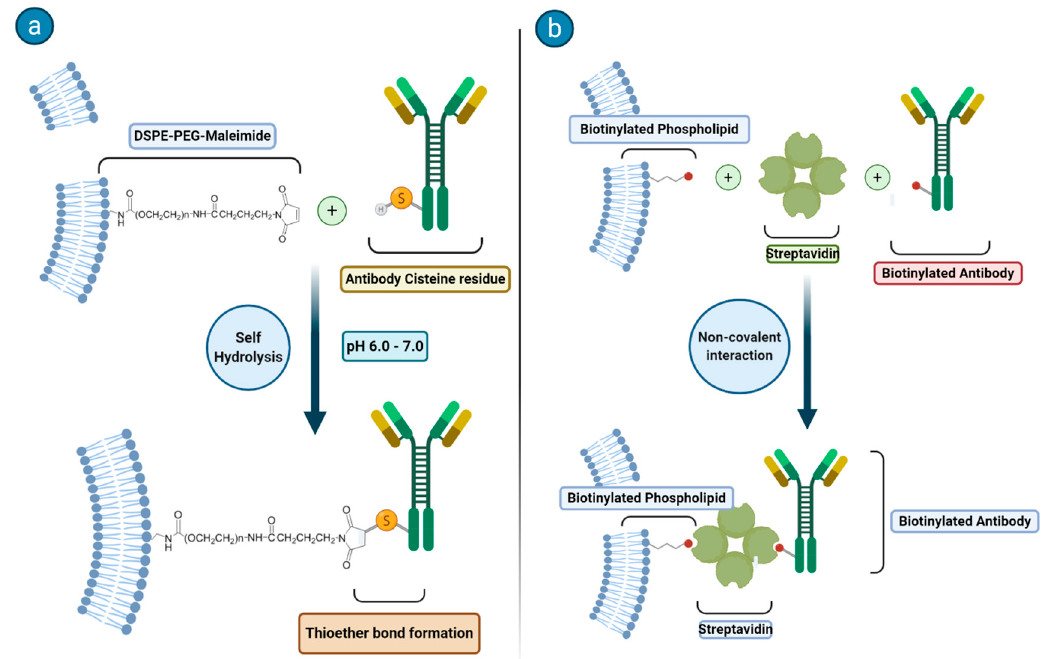
Figure 2. Two synthetic strategies for immunoliposome formation. ( a ) Some of the phospholipids of the lipid bylayer are functionalized with a maleimide moiety that will react with a cisteine residue present on the antibody to form a thioeter bond. ( b ) Liposomes that expose biotin residues on their surface first bind to streptavidin, which contains four high a ffi nity biotin binding sites, and next a biotinylated antibody recognizes an untaken biotin site on the protein yielding to the formation of the antibody-functionalized liposome.